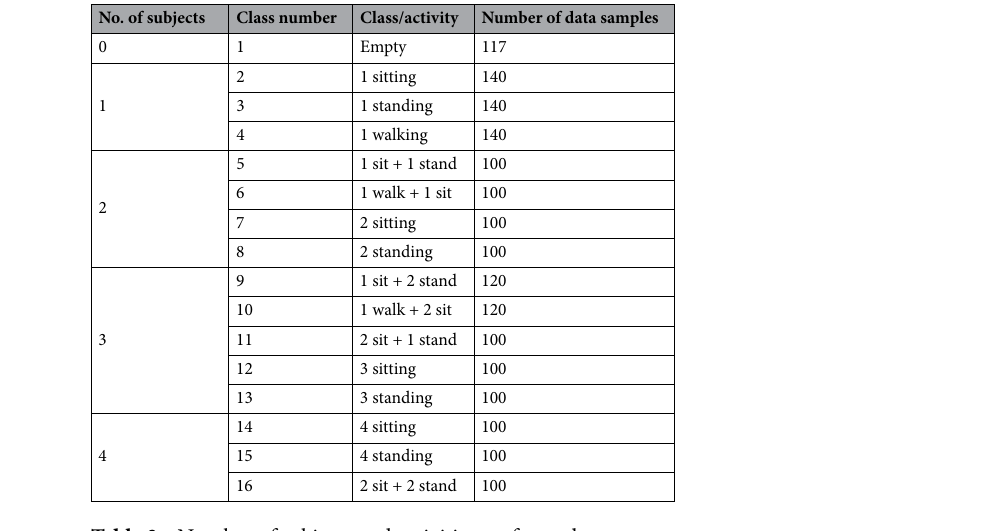
Table 2. Number of subjects and activities